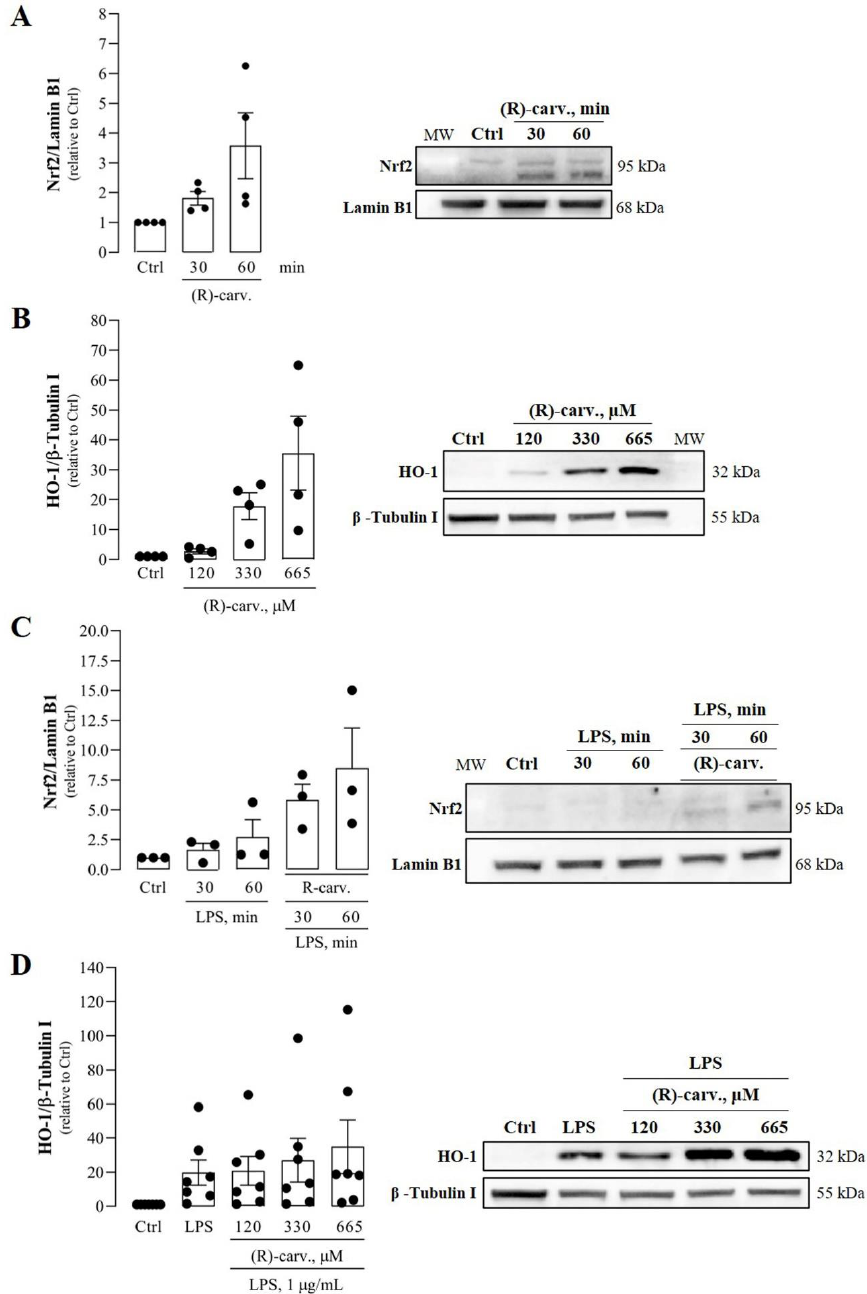
Figure 7. Effect of (R)-(-)-carvone on nuclear Nrf2 and Heme-oxygenase 1 (HO-1) levels in the absence ( A , B ) and presence ( C , D ) of LPS. In ( A , B ) , macrophages were treated with the vehicle (0.1% DMSO), 665 µM or the indicated concentrations of (R)-(-)-carvone for the time periods indicated ( A ) or for 18 h ( C ). In ( C , D ), macrophages were pre-treated with the vehicle (0.1% DMSO), 665 µM or the indicated concentrations of (R)-(-)-carvone for 1 h, followed by the addition of 1 µ g/mL LPS for the time periods indicated ( B ) or for18 h ( D ). In all panels, control cells (Ctrl) were treated with the vehicle (0.1% DMSO) alone. Each column represents the mean ± SEM of four ( A , B ), three ( C ) or seven ( D ) independent experiments. Supplementary Table S3 show the raw data of the results presented in each panel. Representative images are shown. The corresponding images of the full-length blots are shown in Supplementary Figure S1. MW: molecular weight